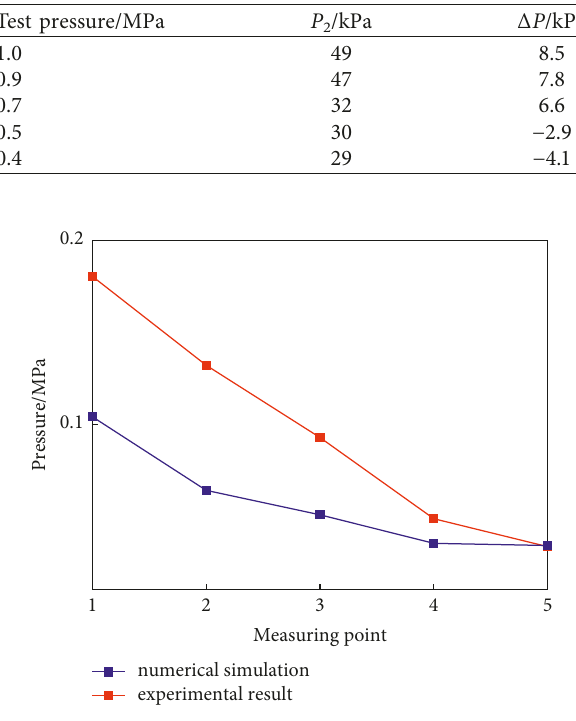
Figure 6: Comparison of experimental and simulated shock wave